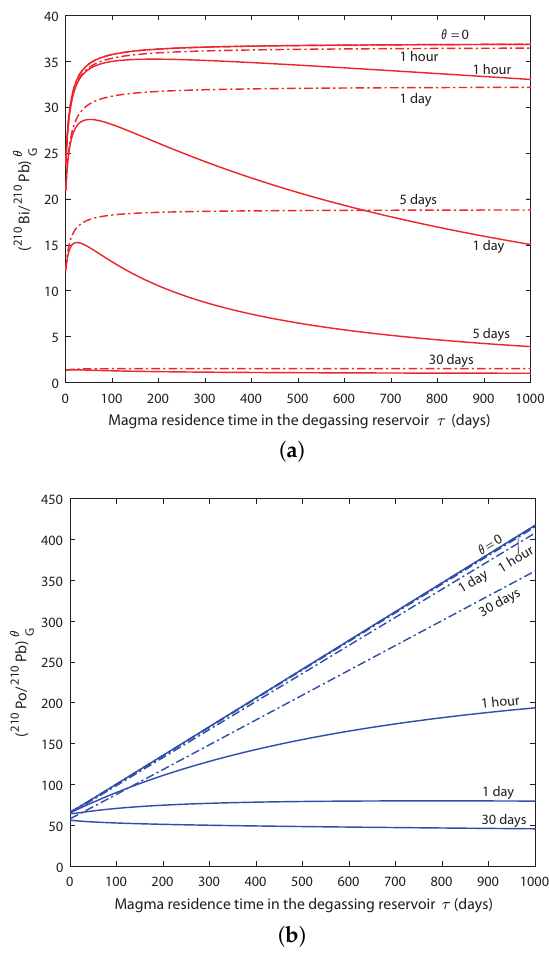
Figure 4. Radioactive disequilibria ( a ) ( 210 Bi/ 210 Pb) and ( b ) ( 210 Po/ 210 Pb) in the gas phase versus magma residence time in the degassing reservoir according to the new model (plain lines) and according the model of Gauthier et al. [15] (dashed lines). Curves for several values of transfer time θ (0, 1 h, 1, 5 and 30 days) are drawn. Fixed parameters of the model are α = 5wt.%, f = 1, (cid:101) Pb = 1.5%, (cid:101) Bi = 36% et (cid:101) Po =